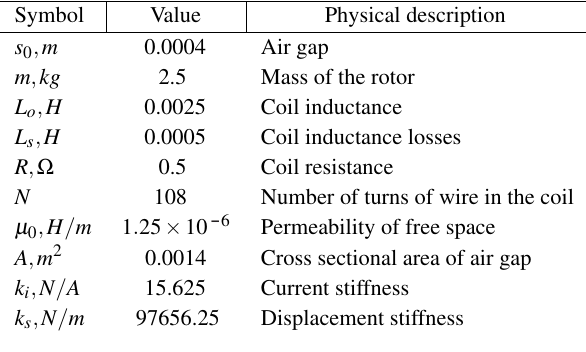
Table 3. Values and descriptions of AMB system parameters